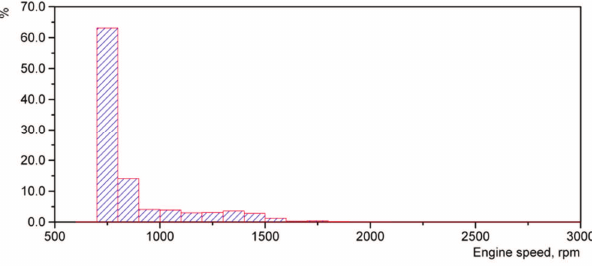
Fig. 8. Histogram for crankshaft speed for urban traffic The load frequency as a function of speed and load is in Fig. 6 and the histograms of the frequency of engine load